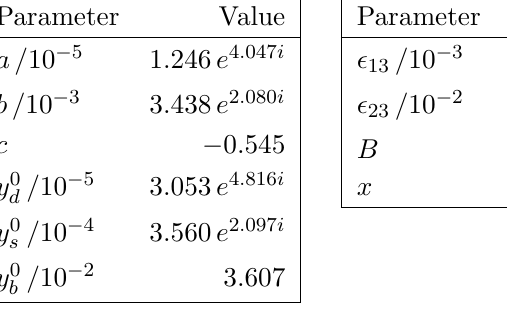
Table 9 . Best (cid:12)t input parameter